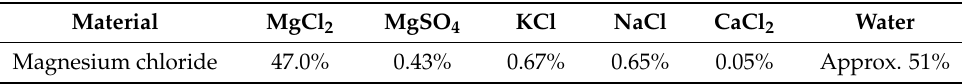
Table 2. Chemical compositions of the technical magnesium chloride.